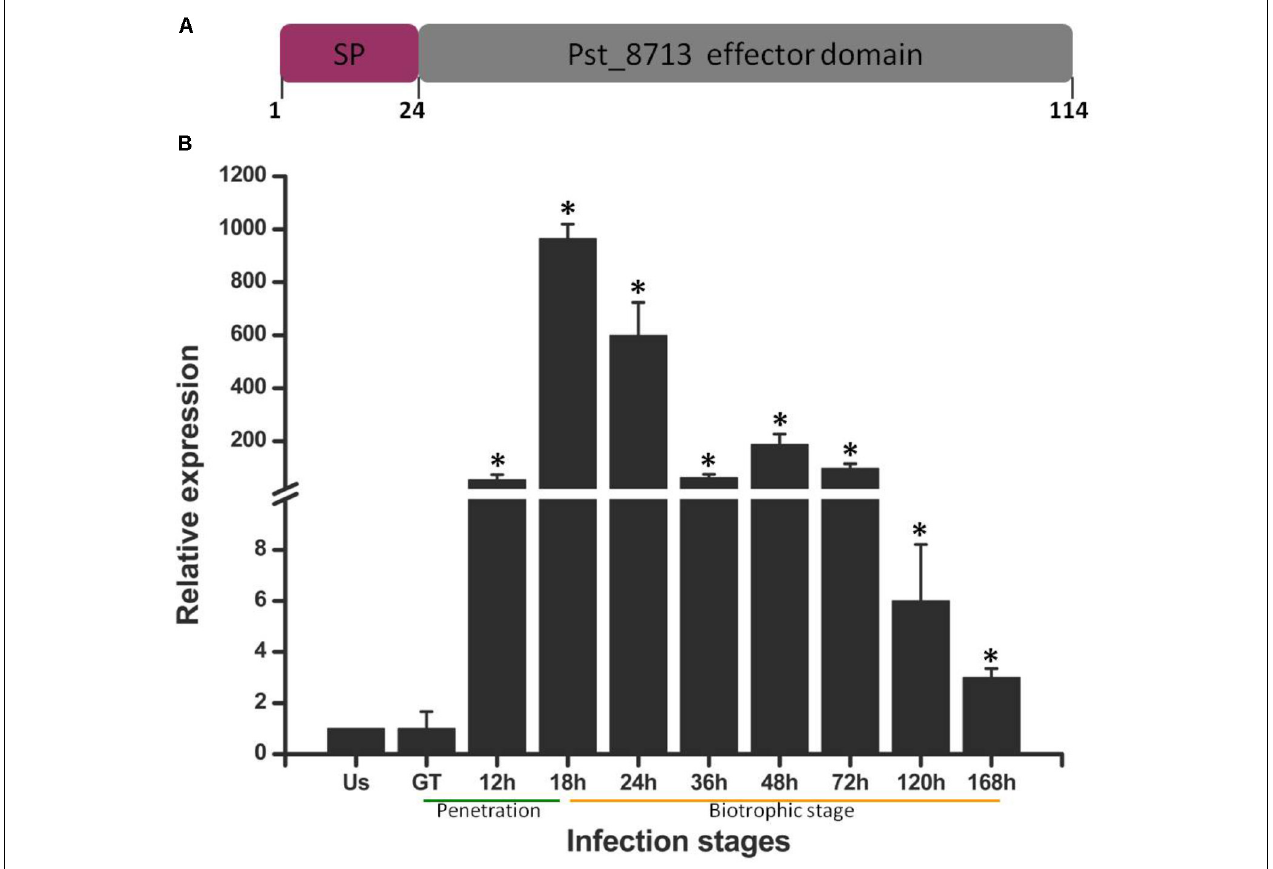
FIGURE 1 | Pst_8713 is significantly up-regulated during Pst -infection of wheat. (A) The primary structure of Pst_8713. SP, signal peptide. (B) Transcript levels of Pst_8713 at various stages of Pst infection. US, Urediniospores; GT, Germinated tube of US, 12–168 h, wheat leaves infected with Pst at 18–168 hpi. The relative gene quantification was calculated by the comparative Ct method with Pst endogenous gene EF1 as an internal standard and was relative to that of US. Bars indicate means of three independent biological replicates ( ± SE). Asterisks indicate significant differences ( P < 0.01) relative to the US sample determined using Student’s t -test.